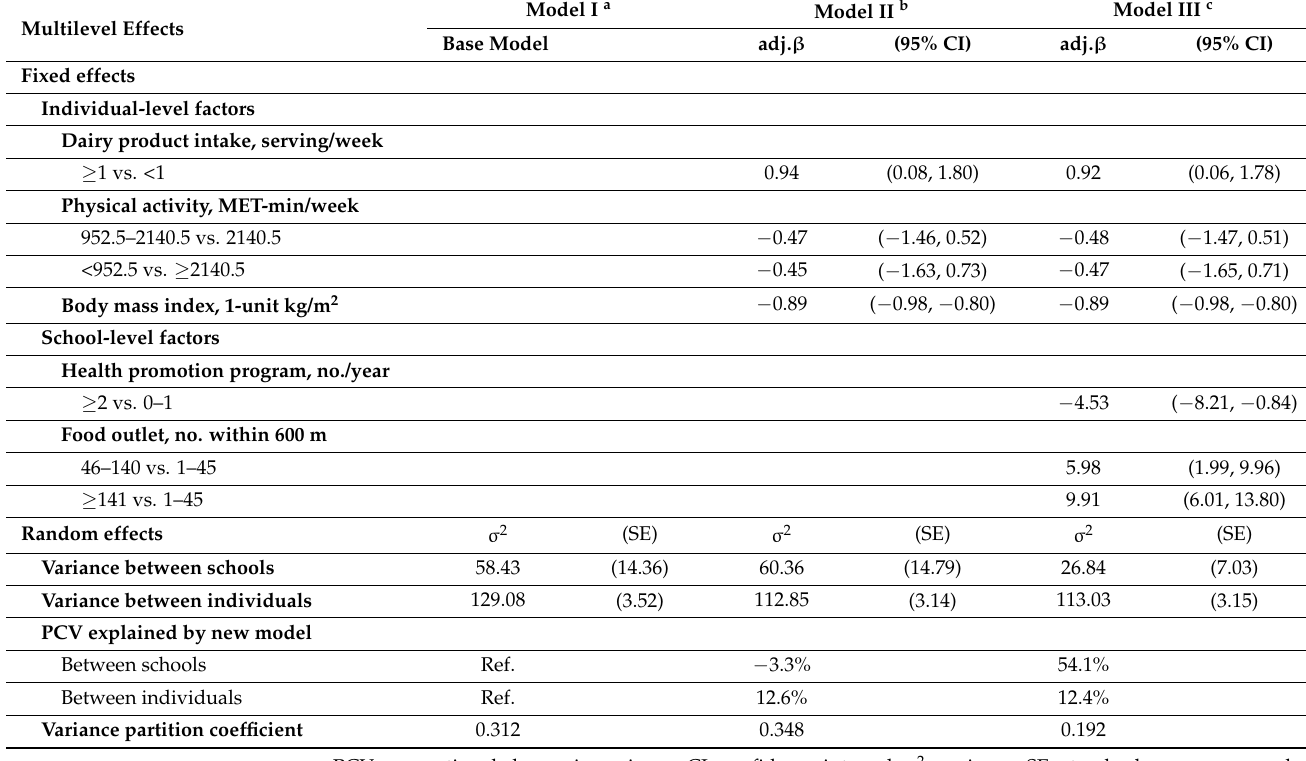
Table 5. The multilevel effects of individual and school factors on high-density lipoprotein cholesterol level (mg/dL) in